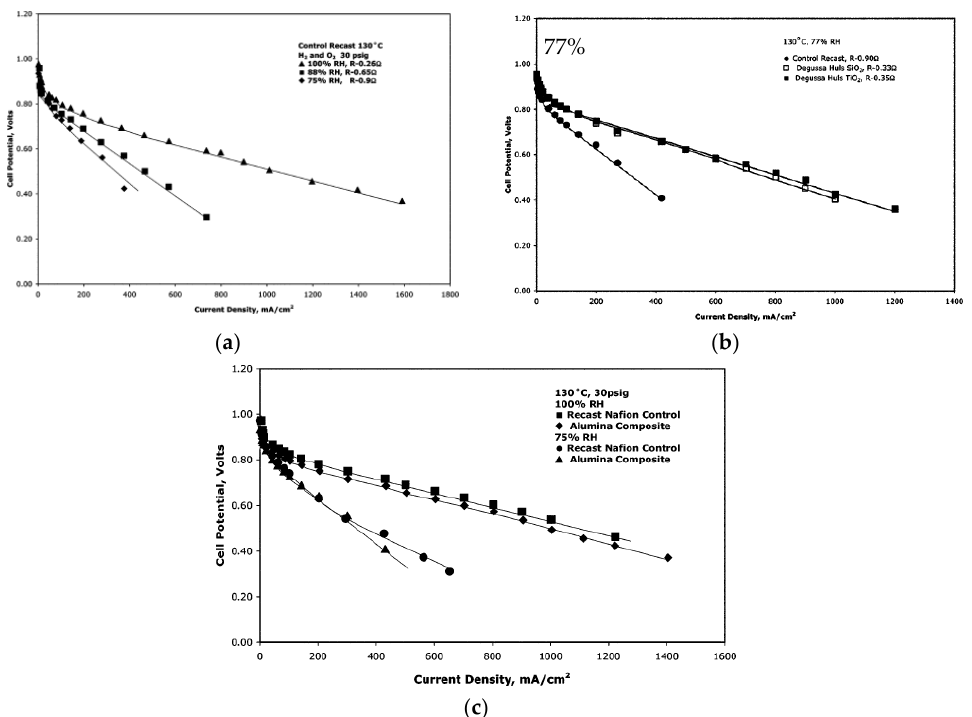
Figure 6. The conductivity of the measured membranes at different water activities at 90 °C ( a ) and 120 °C ( b ) . Reprinted with permission from Ref. [47]. Copyright 2005 Elsevier.